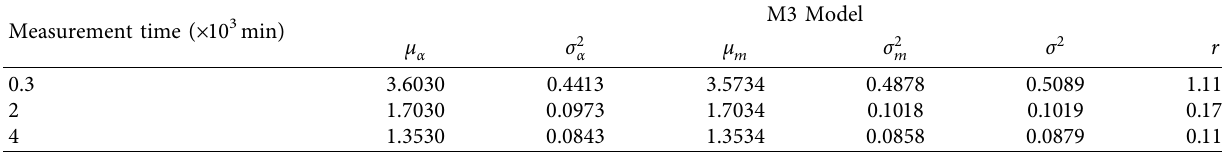
Table 3: Parameter estimation of the M3 model.